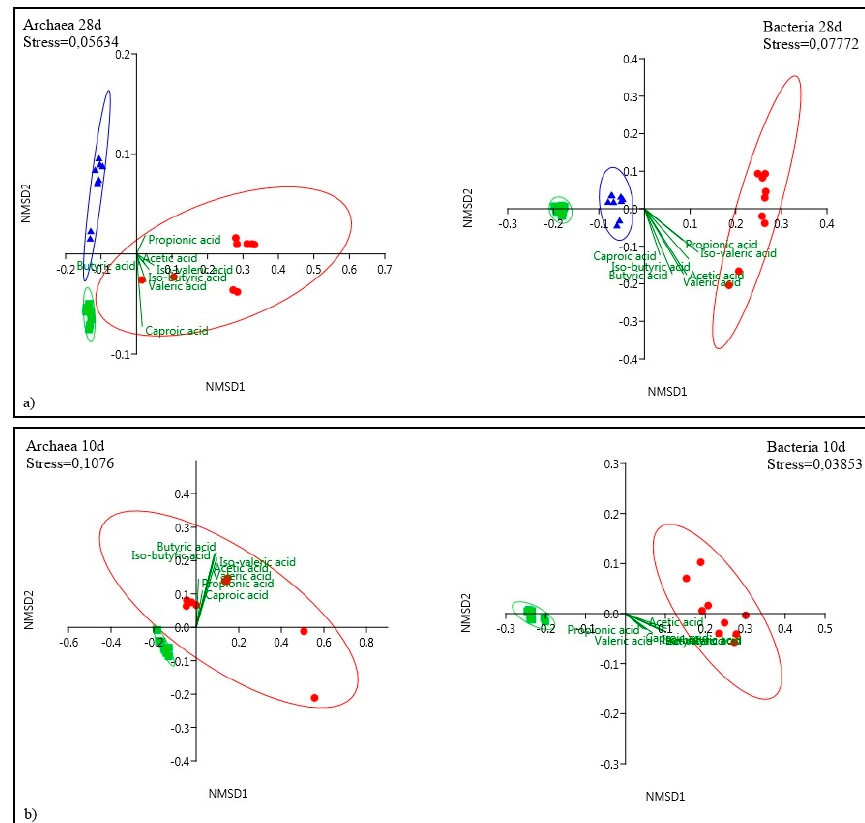
Figure 5. NMDS plots of the ( a ) 28-day experiment and ( b ) 10-day experiment. Bray–Curtis dissimilarity index on Hellinger transformation of the amounts of OTUs has been applied. The ellipses indicate the probability of finding the samples with a 95% interval of confidence. Individual samples are represented by symbols, colored based on the inoculum treatment: control (square green), freeze-thaw (triangle blue) and thermal (dot red). Shepherds stress is indicated on the plots.